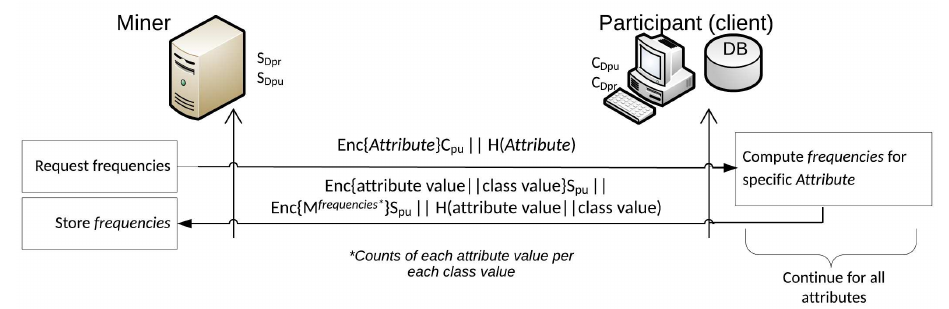
Figure 4. Data collection